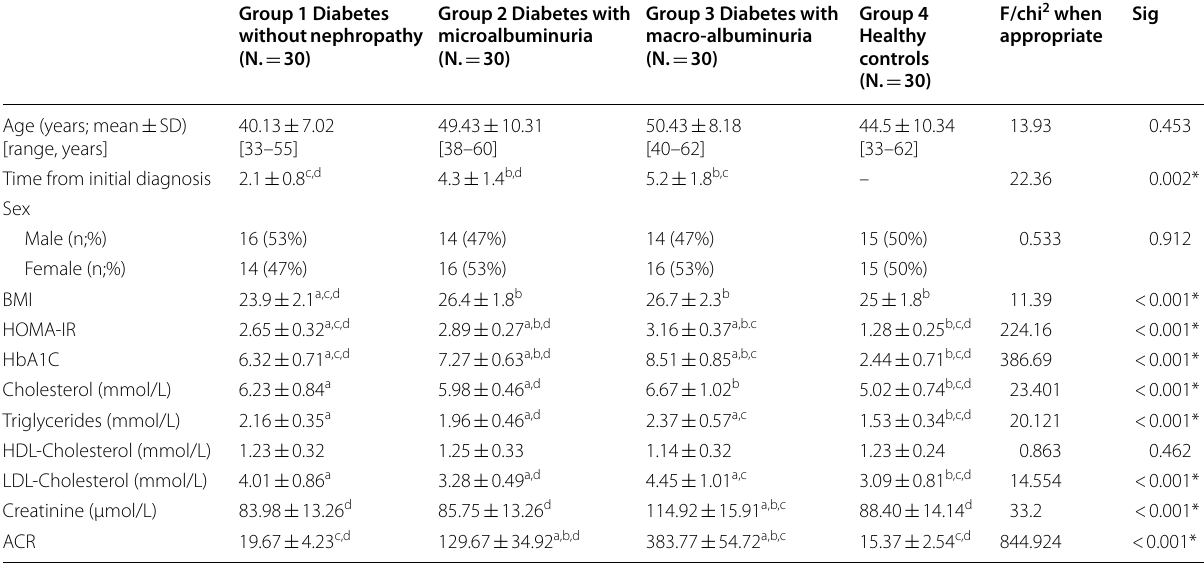
ANOVA analysis with post hoc Tukey’s test; (*) indicates statistical significance), data is presented as mean